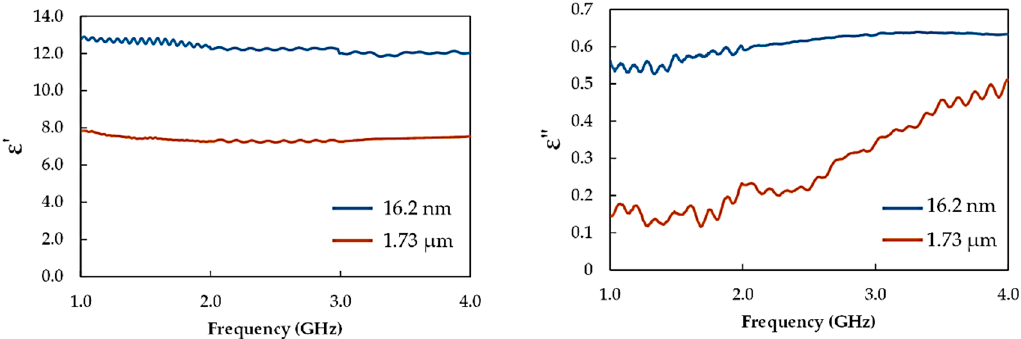
Figure 7. Complex permittivity of recycled α -Fe 2 O 3 particles.